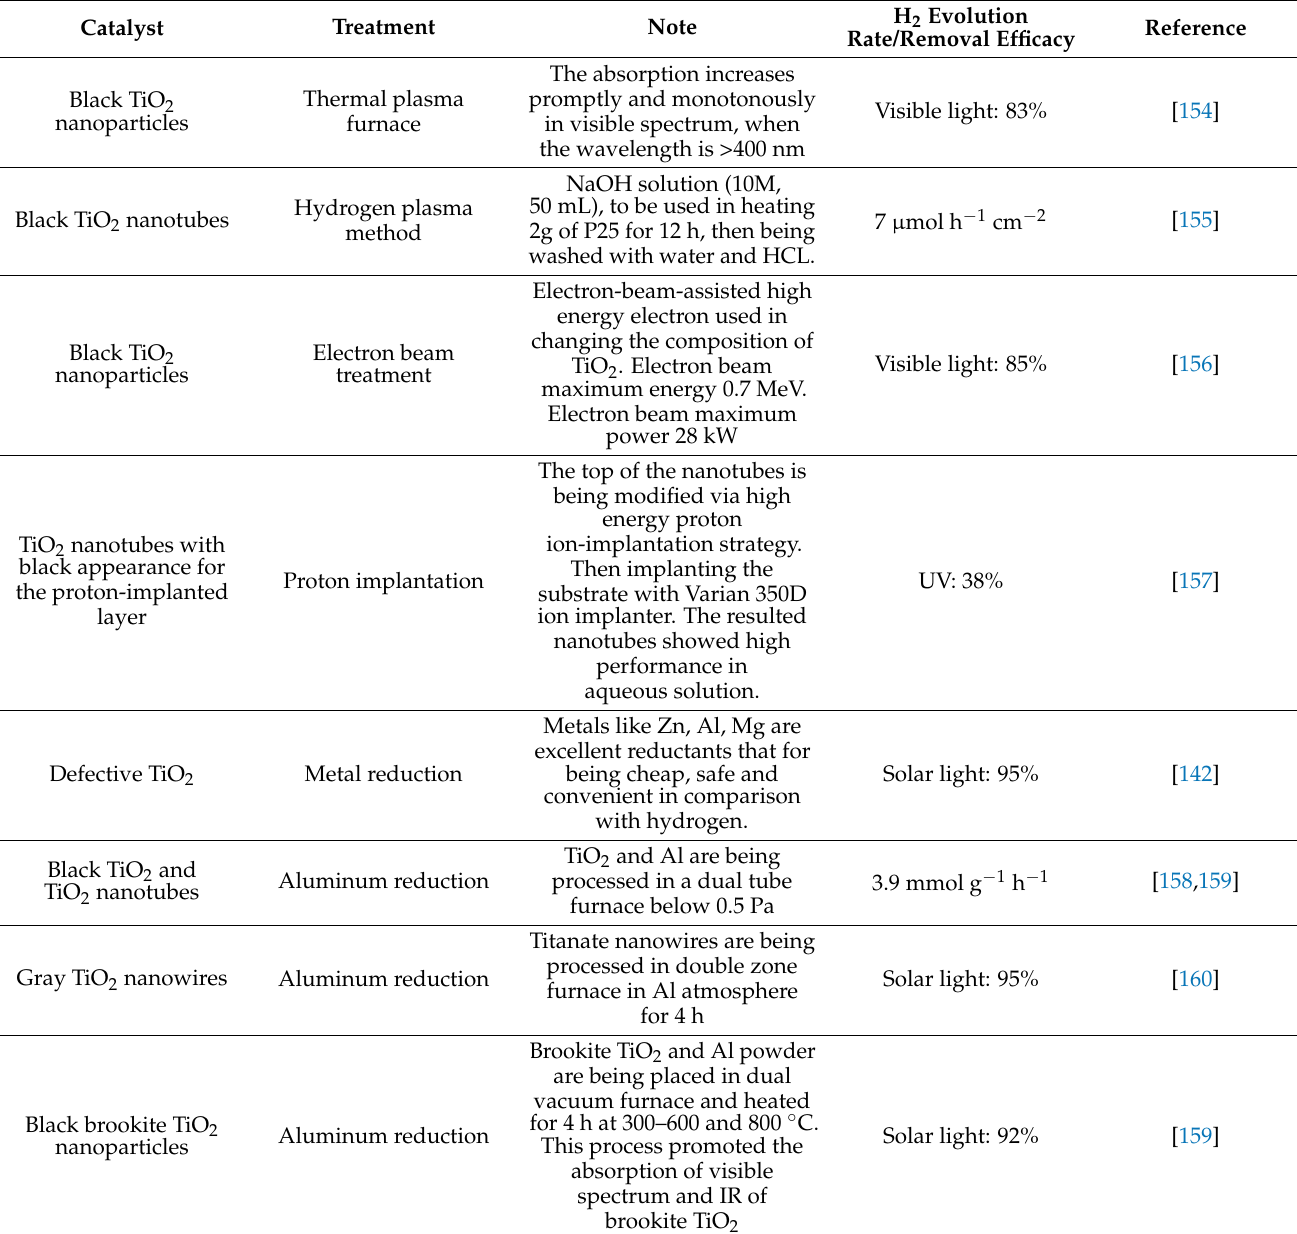
Table 1. Various techniques for the synthesis of hydrogenated TiO 2 materials and their features in the synthesis